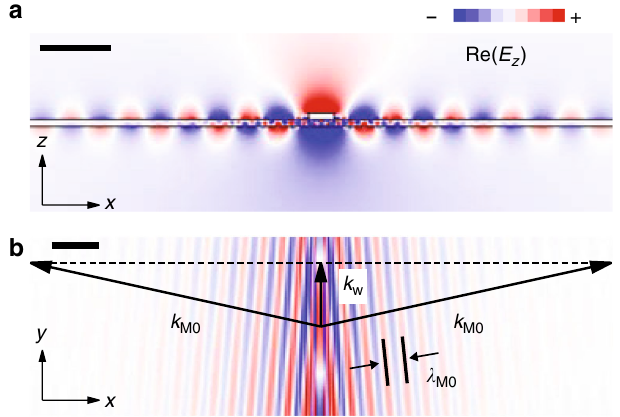
Fig. 3 Leakage of the waveguiding HPhP mode below the Au rod into the HPhP M0 mode in the h-BN fl ake. a , b Spatial distribution of the z- component of the electric fi eld in the z – x ( a ) and x – y (at the top surface of the h-BN slab) ( b ) planes, calculated at ω = 1520 cm − 1 . The cross-section of the waveguide is that of the rod antennas. Scale bars, 0.5 μ m in a